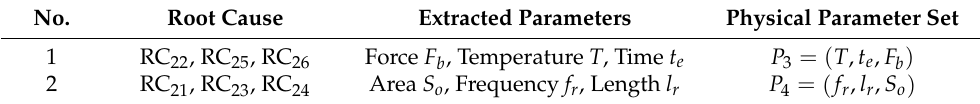
Table 9. Physical parameters extracted from root causes of “TCM accumulation at outlet”.